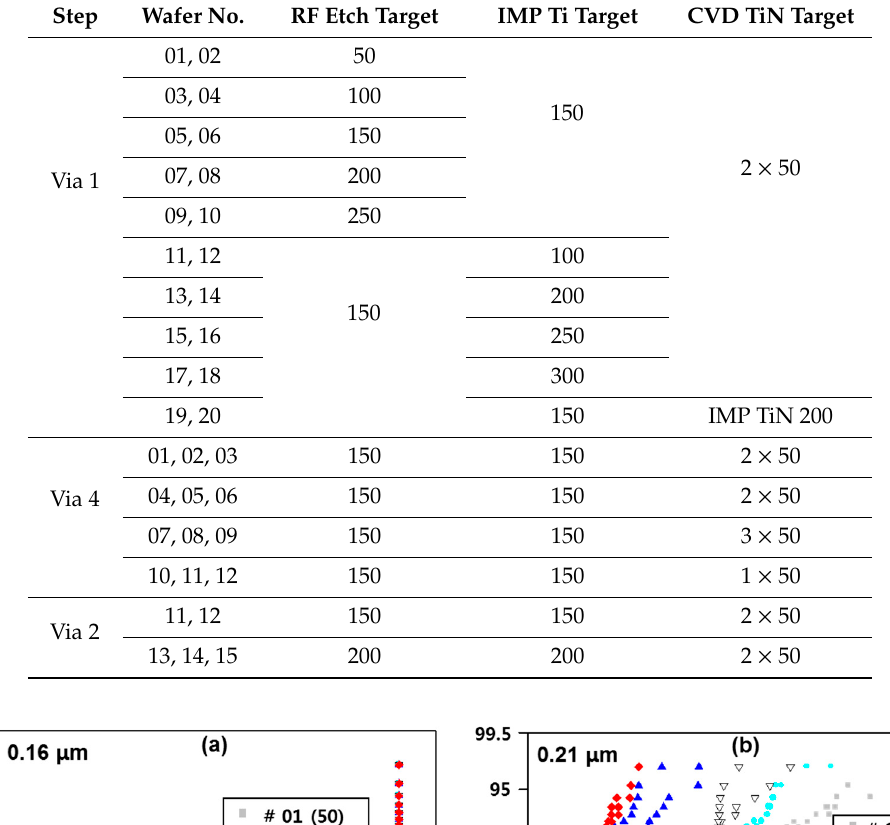
Table 3. Split item for each step.